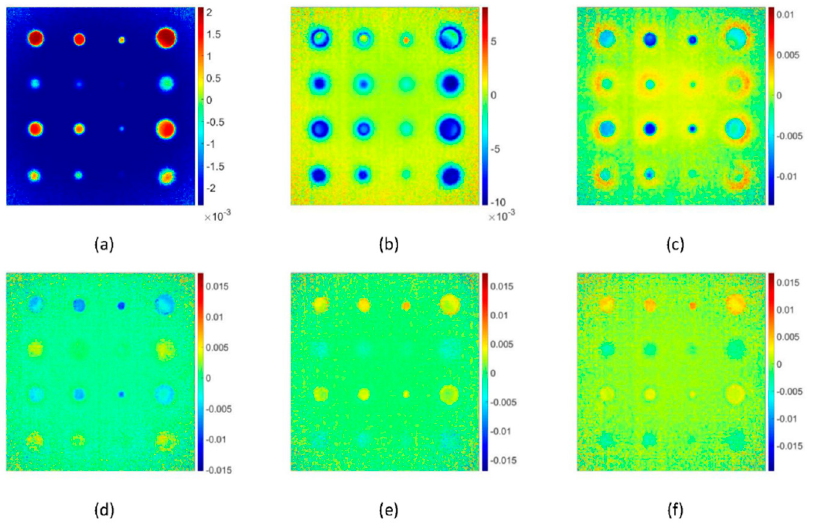
Figure 11. Experimental pulsed thermography images processed by principle component thermography concerning EOFs, ( a ) 1st EOF, ( b ) 2nd EOF, ( c ) 3rd EOF, ( d ) 4th EOF, ( e ) 5th EOF and ( f ) 6th EOF. The scales are in “digital level” units.